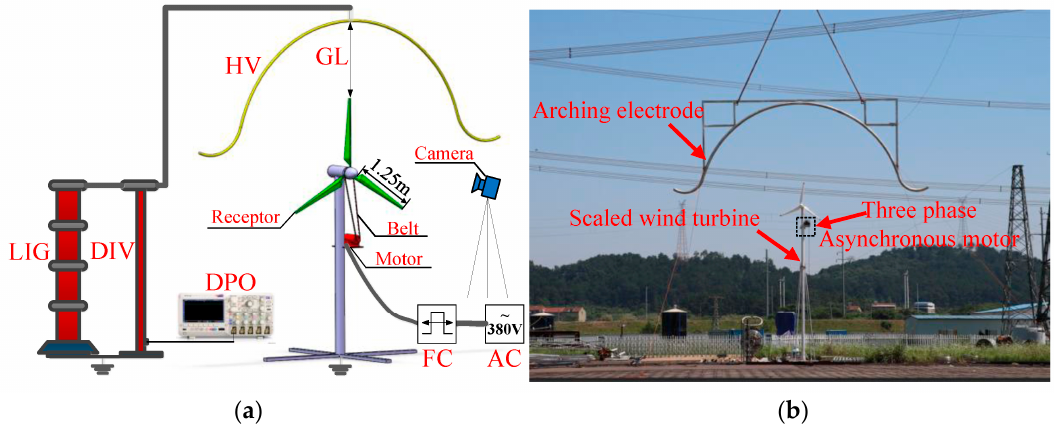
Figure 2. Test arrangement: ( a ) test model configuration; ( b ) diagram of scale model. AC: three-phase supply; DIV: capacitance divider; DPO: digital oscilloscope; FC: frequency converter; GL: gap